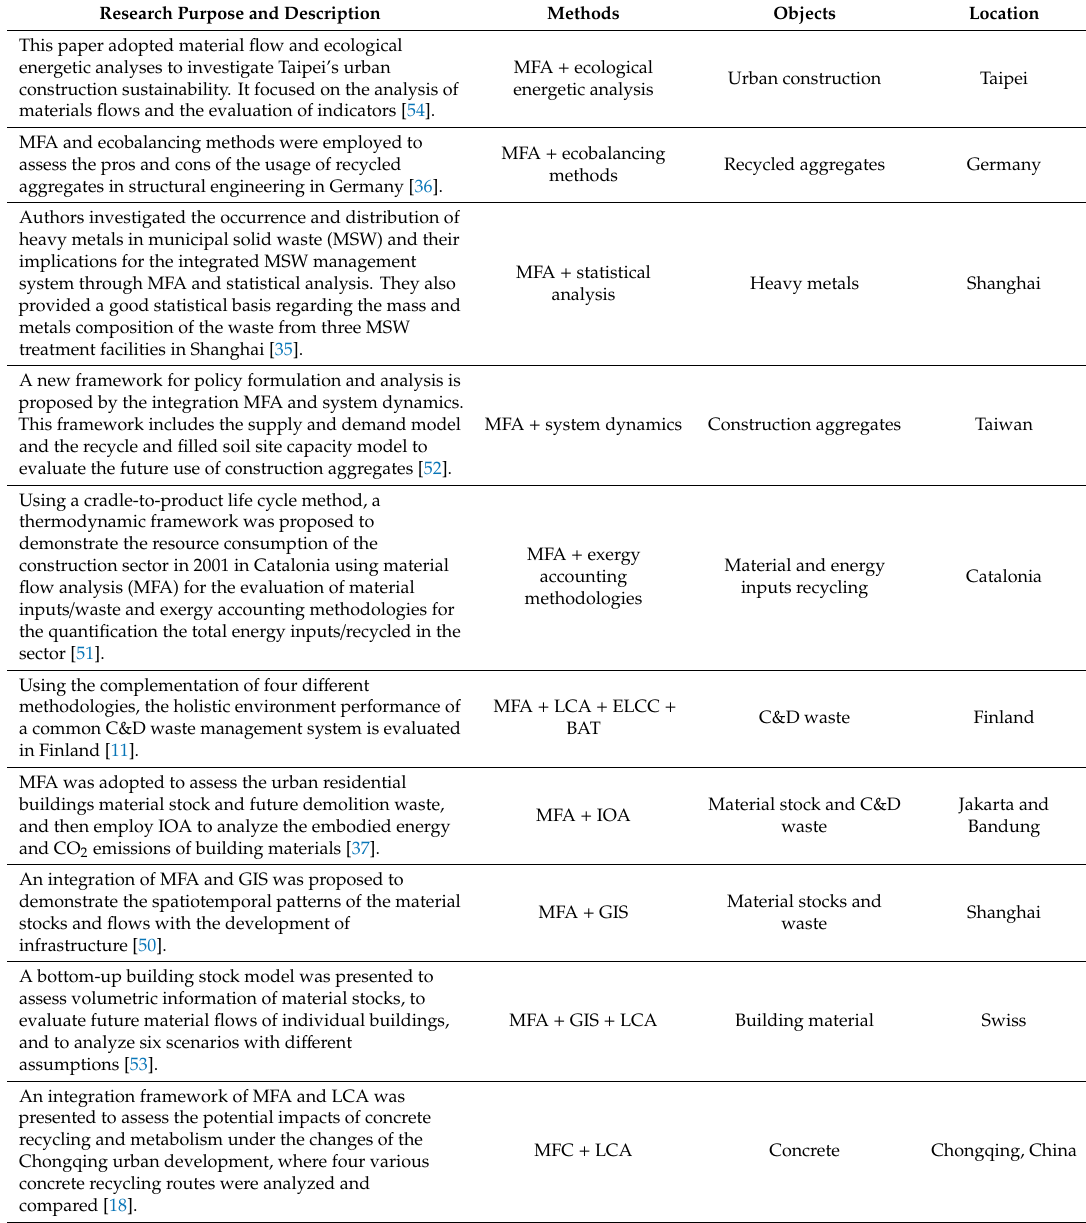
Table 4. Summary and analysis of C&D waste processing based on combination